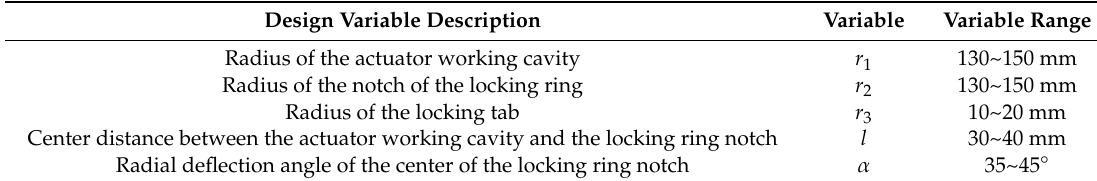
Table 3. The design variable ranges.